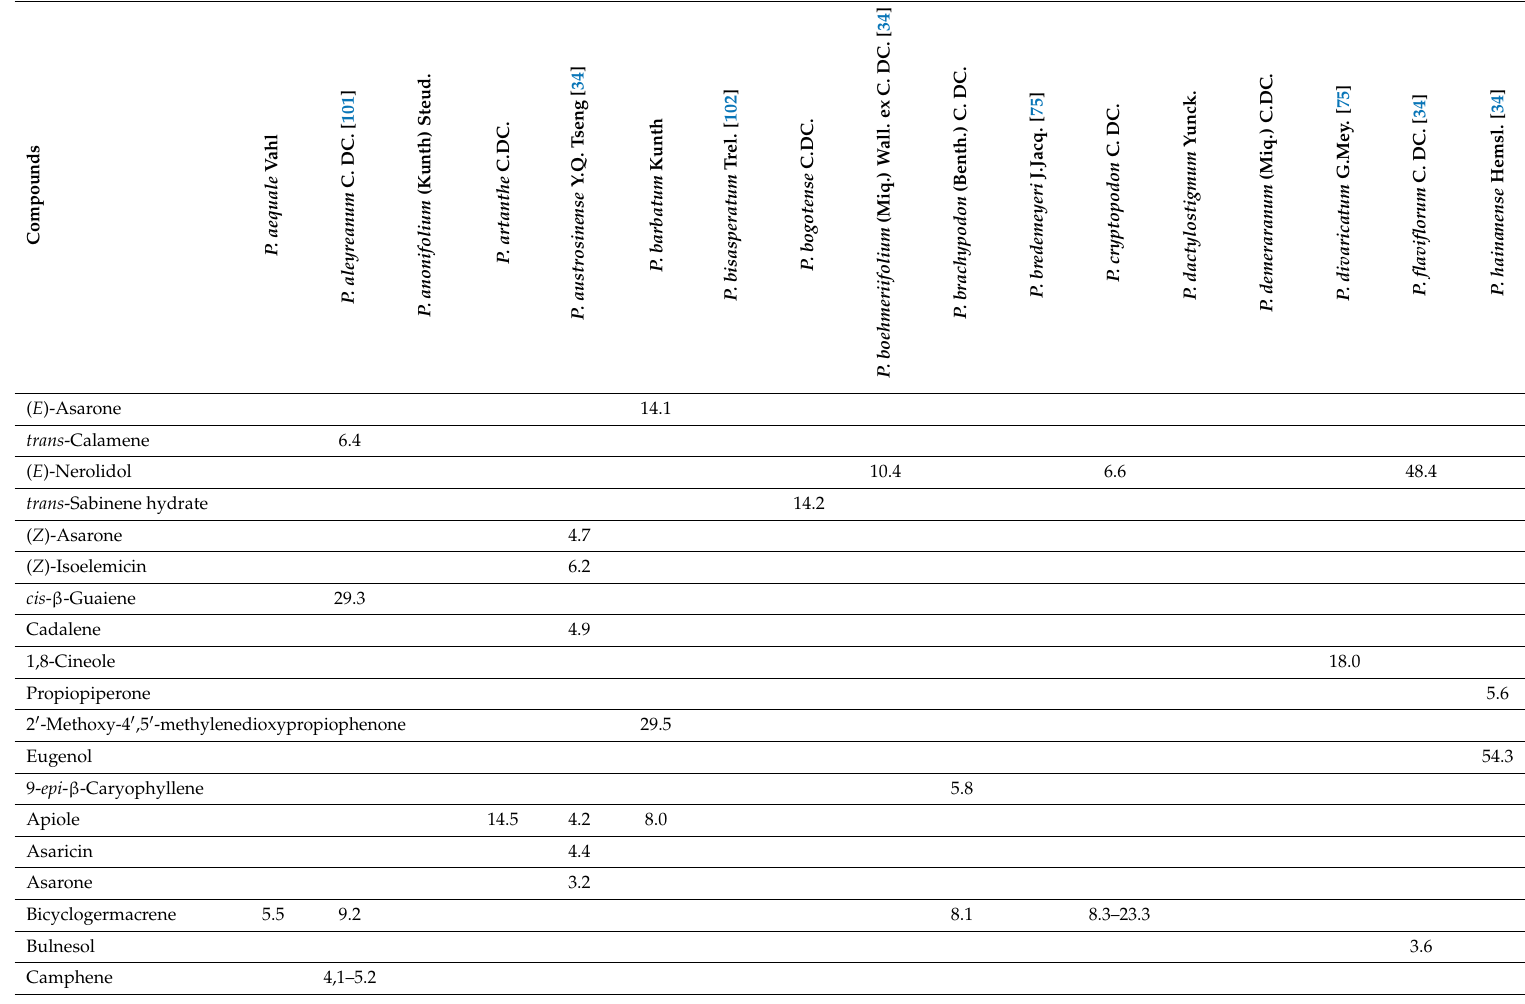
Table 26. Chemical compositions (%) of aerial parts essential oils from miscellaneous Piper species, part